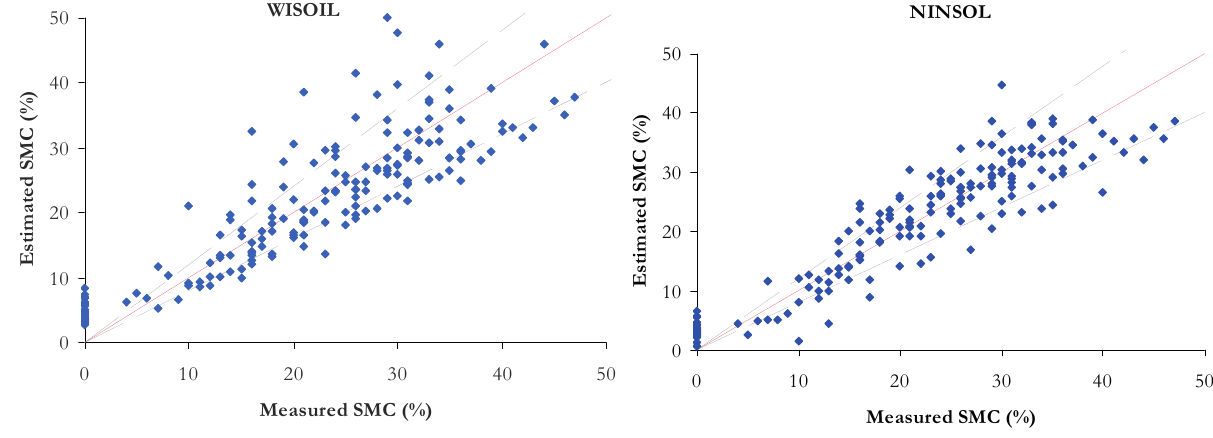
Figure 8. Representation of estimated SMC according to measured SMC for WISOIL ( Left ) and NINSOL ( Right ). The dashed black lines represent the boundaries of an error of